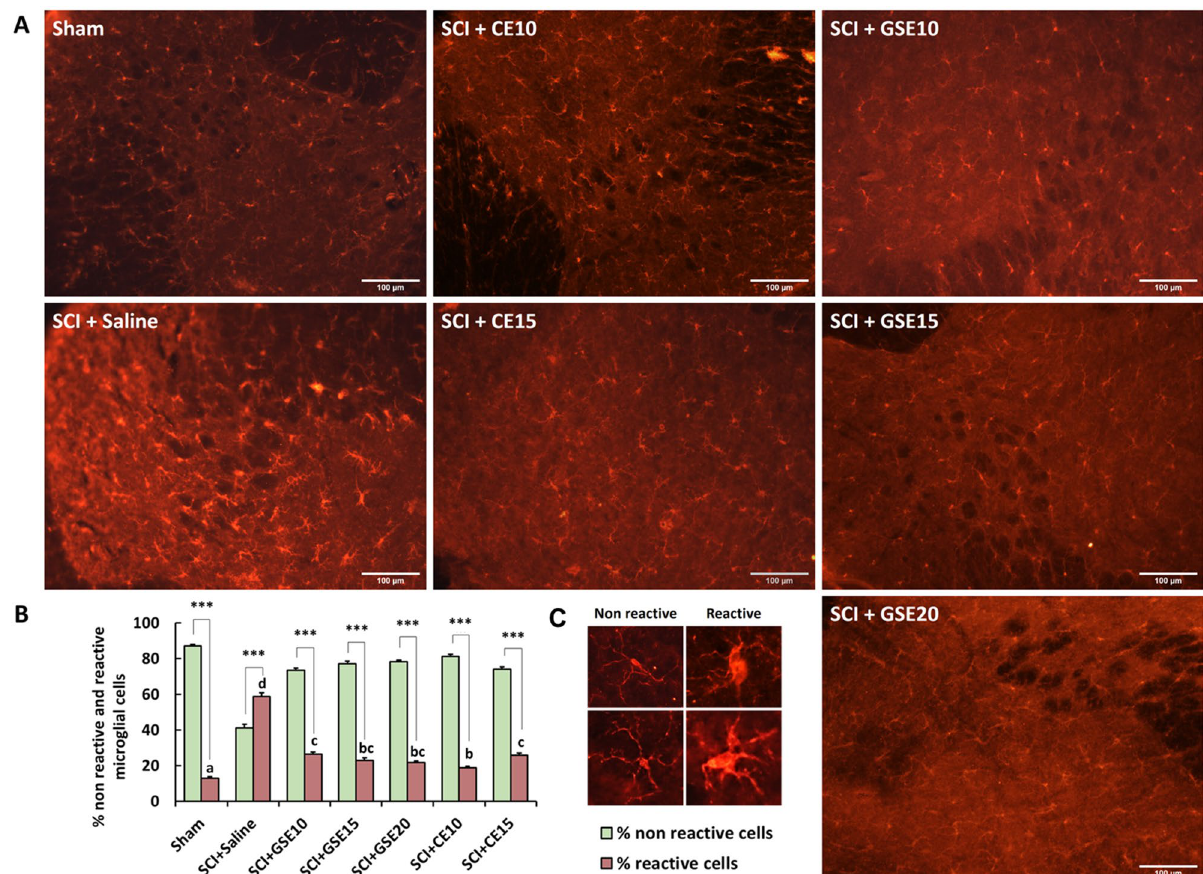
Figure 5. Effects of GSE and CE treatments on spinal IBA1 immunoreactivity in SCI mice at the end of the experimental period. ( A ) Representative histological images of the spinal cord immunostained against IBA1 of each group (scale bar 100 μm). ( B ) Histogram representing the percentage of reactive and nonreactive microglial cells in the spinal dorsal horn. ( C ) Examples of nonreactive and reactive microglial cells. Note that reactive cells have an amoeboid form, a larger nucleus and shorter branching processes than nonreactive cells. Images were captured at the same regions where astrogliosis was analyzed Data are expressed as the mean ± SEM. a–d: Groups not sharing a letter showed significant differences in %reactive cells, p < 0.05. Intragroup significant differences: *** p < 0.001%nonreactive vs %reactive. Experimental groups: Sham (n = 6; slices = 53), SCI + Saline (n = 5; slices = 34), SCI + GSE10 (n = 6; slices = 65), SCI + GSE15 (n = 4; slices = 47), SCI + GSE20 (n = 6; slices = 78), SCI + CE10 (n = 5; slices = 67), SCI + CE15 (n = 4; slices =